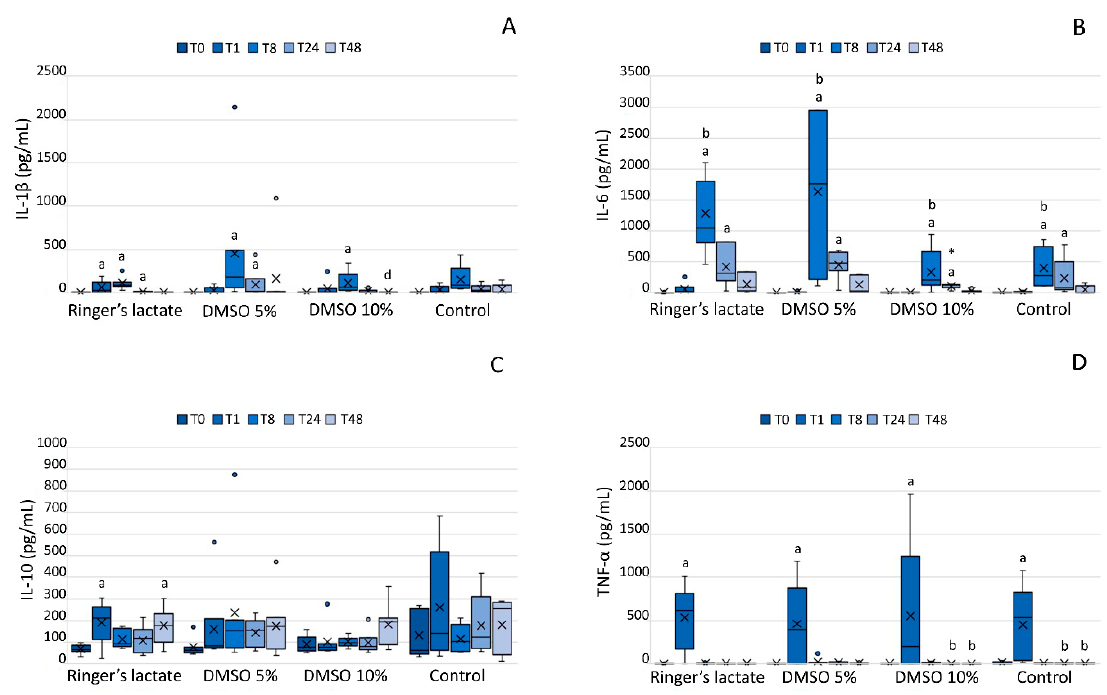
Figure 3. Interleukin (IL)-1 β ( A ), IL-6 ( B ), IL-10 ( C ), and tumor necrosis factor (TNF)- α ( D ) concentrations (pg / mL) in the synovial fluid. IL-1 β , IL-6, IL-10, and TNF- α concentrations (pg / mL) in the synovial fluid are shown as box plots, indicating the median ( − ), mean ( × ), and first and third quartiles. a Statistically significant di ff erences compared to the baseline values ( p < 0.05); b Statistically significant di ff erences compared to T1 ( p < 0.05); d Statistically significant di ff erences compared to T8 ( p < 0.05). * Statistically significant di ff erences compared to the 5% DMSO and the lactated Ringer’s group ( p < 0.05).